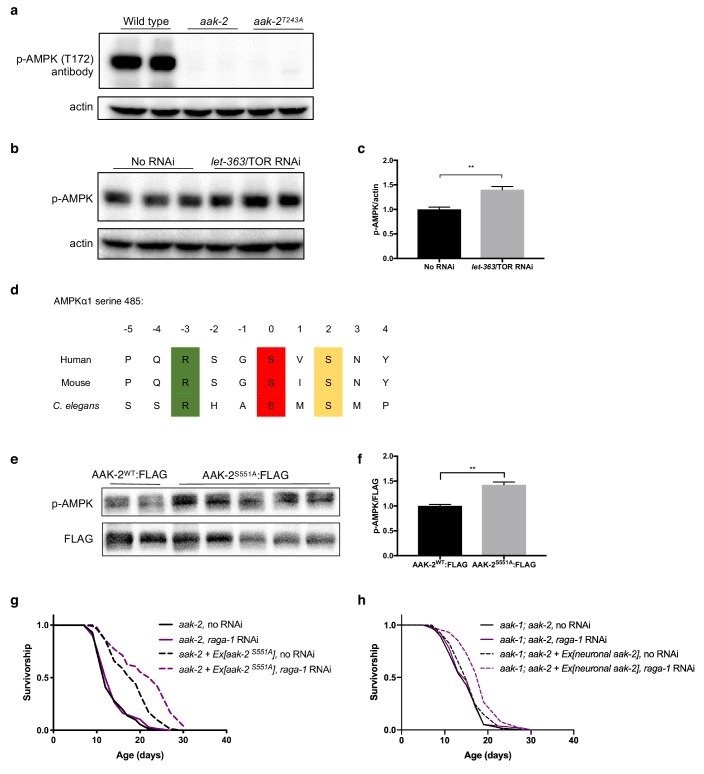
Conservation of critical residues in AAK-2 and their requirement for TORC1-mediated longevity.(a) Western blot showing that a threonine-to-alanine mutation at T243 generated by CRISPR on aak-2 completely loses recognition for antibodies against phosphorylation at the conserved residue T172 in mammalian AMPKα. aak-2(ok524) mutants, which carry a 408 bp deletion spanning T243, are used as controls (representative immunoblot, n = 3 independent blots). (b, c) Western blot showing that AMPK T172 phosphorylation is increased in wild type worms treated with let-363 (TOR) RNAi. Actin levels are used as loading controls (representative immunoblot and corresponding quantification, n = 2 independent blots). Source data for quantification are provided in Figure 1—figure supplement 1—source data 1. (d) Alignment of C. elegans AAK-2 and human and mouse AMPKα1 around serine 485 showing the S6K target site is conserved in C. elegans.. (e, f) AMPK T172 phosphorylation is increased in strains overexpressing FLAG-tagged AAK-2 with serine-to-alanine mutation at the conserved S6K/Akt phosphorylation site S551 compared to wild type AAK-2. Actin levels are used as loading controls (quantification of n = 1 blot with two biological replicates for wild type AAK-2 and 5 biological replicates for AAK-2S551A). Source data for quantification are provided in Figure 1—figure supplement 1—source data 2. (g) raga-1 RNAi from day 1 of adulthood can still extend lifespan in aak-2(ok524) animals expressing AAK-2S551A (n = 2, sample size 53–98 deaths per treatment each replicate). Details on strains and lifespan replicates can be found in Supplementary file 6. (h) Pan-neuronal expression of full-length aak-2 rescues lifespan extension from raga-1 RNAi in aak-1; aak-2 double mutant background (p<0.0001, n = 1, sample size 58–80 deaths per treatment). P values are calculated with Log-rank (Mantel-Cox) test. Details on lifespan replicates and strains can be found in Supplementary file 6.10.7554/eLife.49158.005Figure 1—figure supplement 1—source data 1.Figure 1—figure supplement 1c AMPK activity is increased by knockdown of TOR.10.7554/eLife.49158.006Figure 1—figure supplement 1—source data 2.Figure 1—figure supplement 1f The conserved S6K/Akt phosphorylation site serine 551 on AAK-2 modulates AMPK activity.